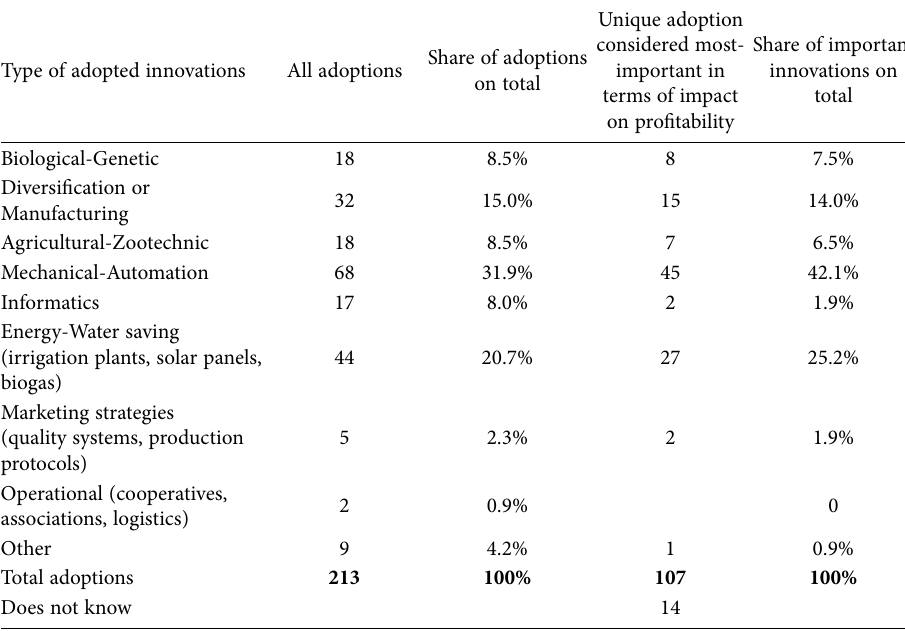
Table 4. Number of innovations introduced in the last 20 years and selection of the most important in terms of